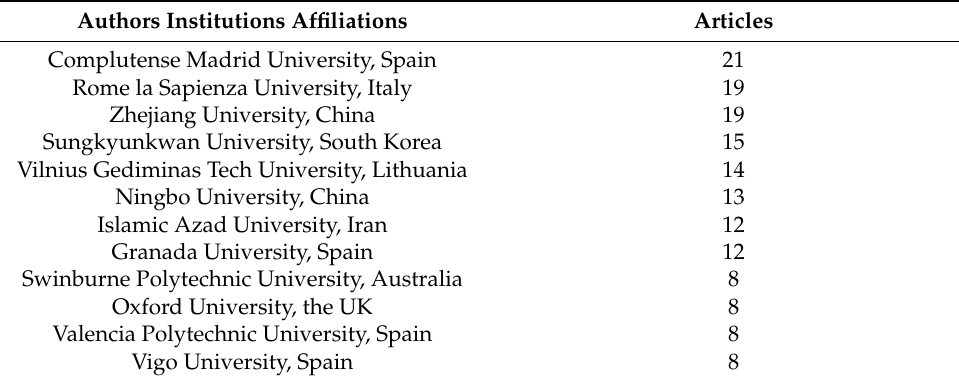
Table 4. Top ten institutions in neuromarketing research